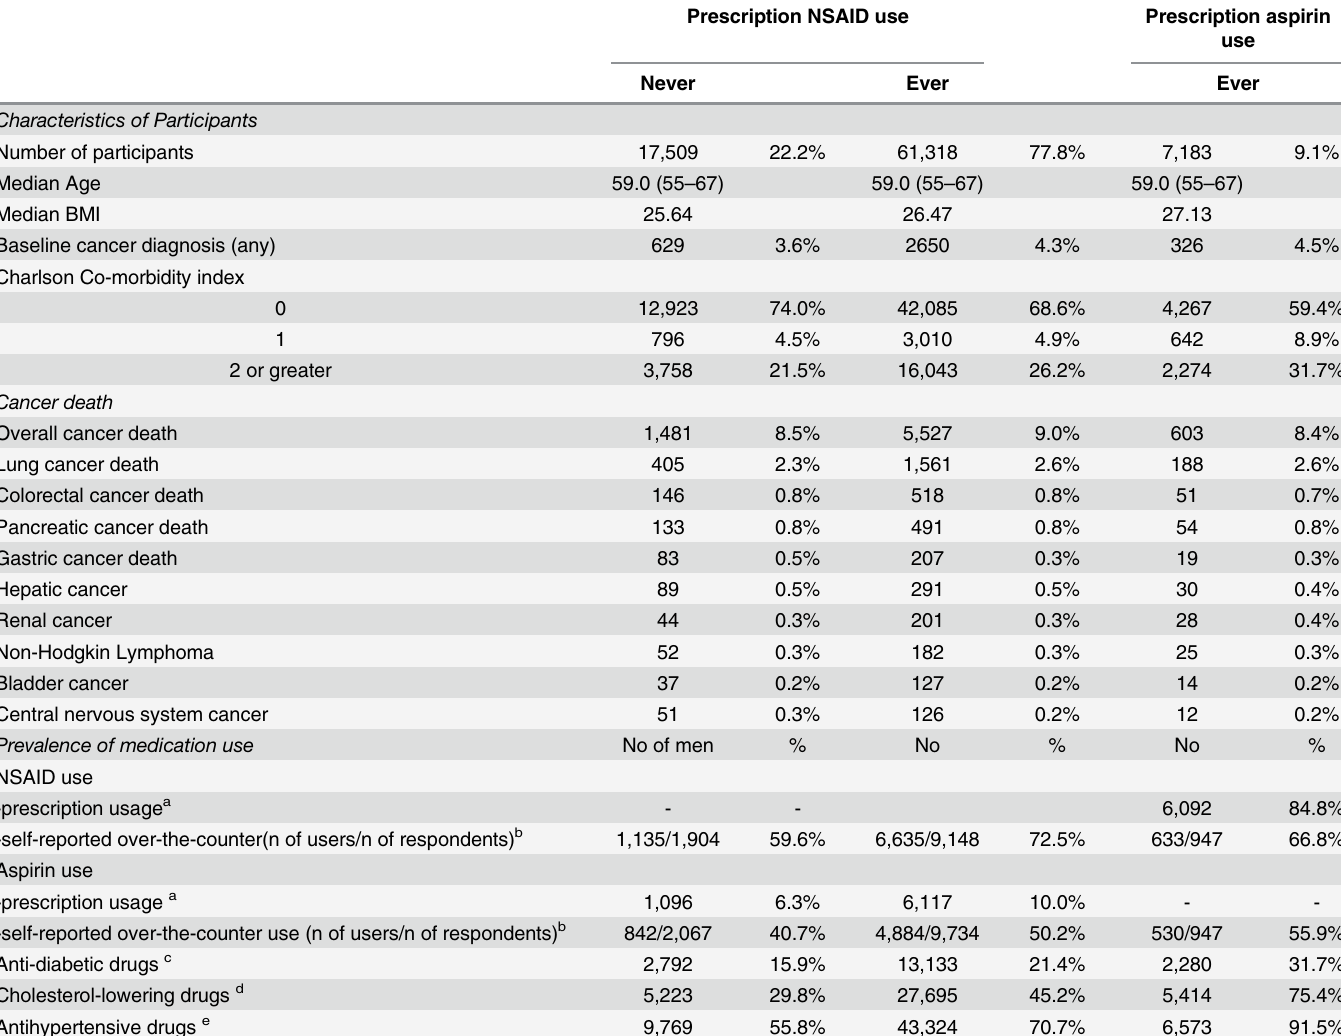
Table 1. Population Characteristics of Prescription Non-steroidal Anti-Inflammatory drug users and non-users in the Finnish Prostate Cancer Screening Trial.